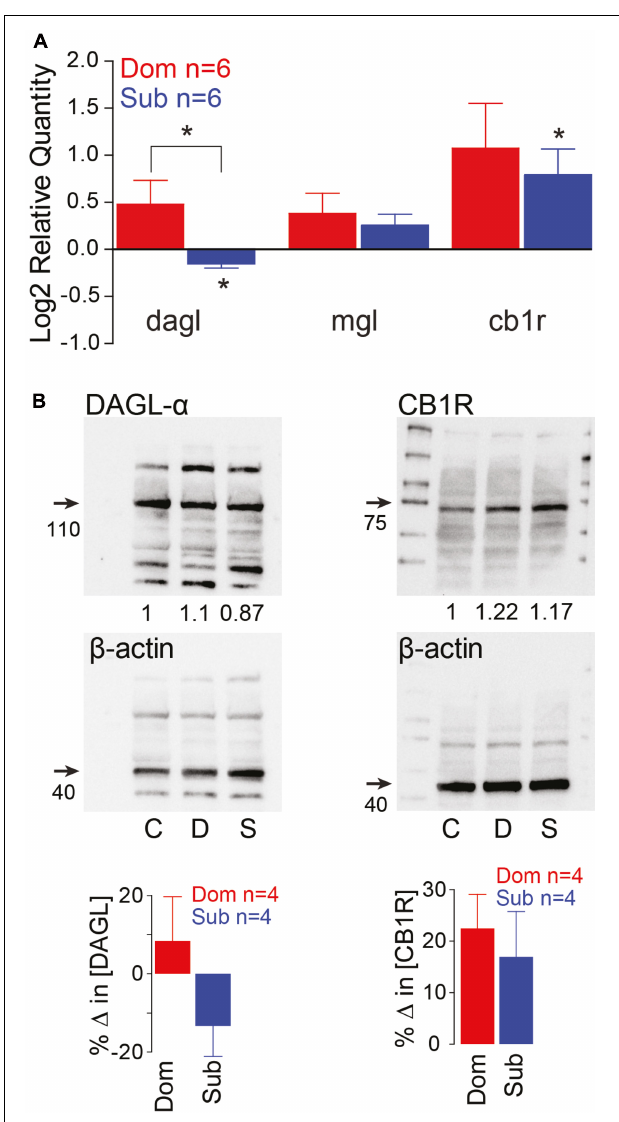
FIGURE 2 | Endocannabinoid signaling pathway is socially regulated and its modulation of M-cell excitability is status-dependent. (A) qPCR gene expression analysis of ECS signaling molecules. Data of dominants and subordinates normalized to control isolates ( n = 6 pairs; control isolates n = 6; Kruskal–Wallis test, * p < 0.05). (B) Western blot analysis of dagl- α and cb1 receptor. Each protein was tested concurrently with β -actin as a control. Protein expression of dominants and subordinates was normalized to communal controls as a ratio (illustrated values below each band); C, communals; D, dominants; S, subordinates. Bar graphs represent average % change in protein concentration of four replicates of samples each consisting of 10 brains normalized to WT communals.